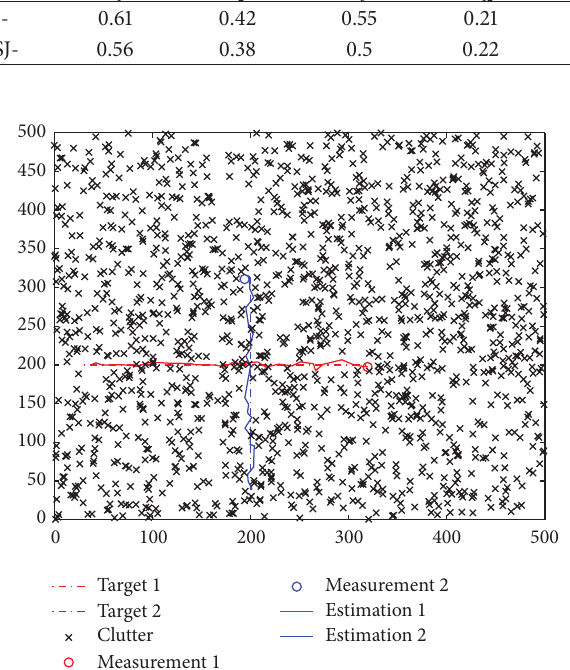
Figure 6: Example of tracking two crossing targets.